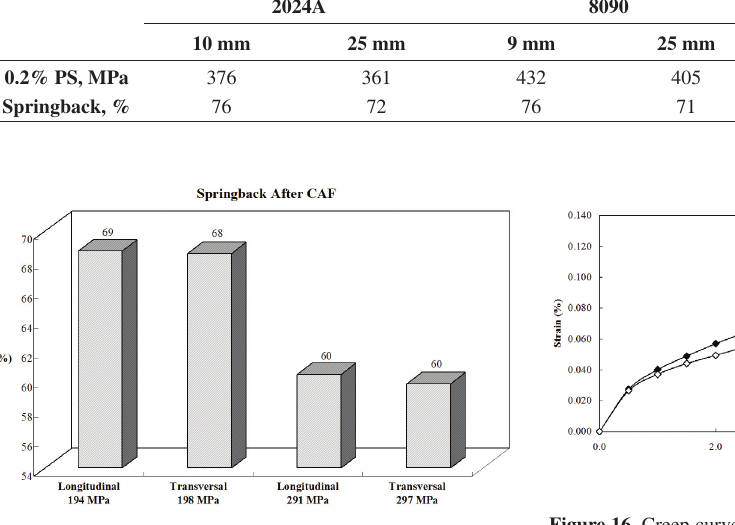
Figure 14. Spring back after CAF.